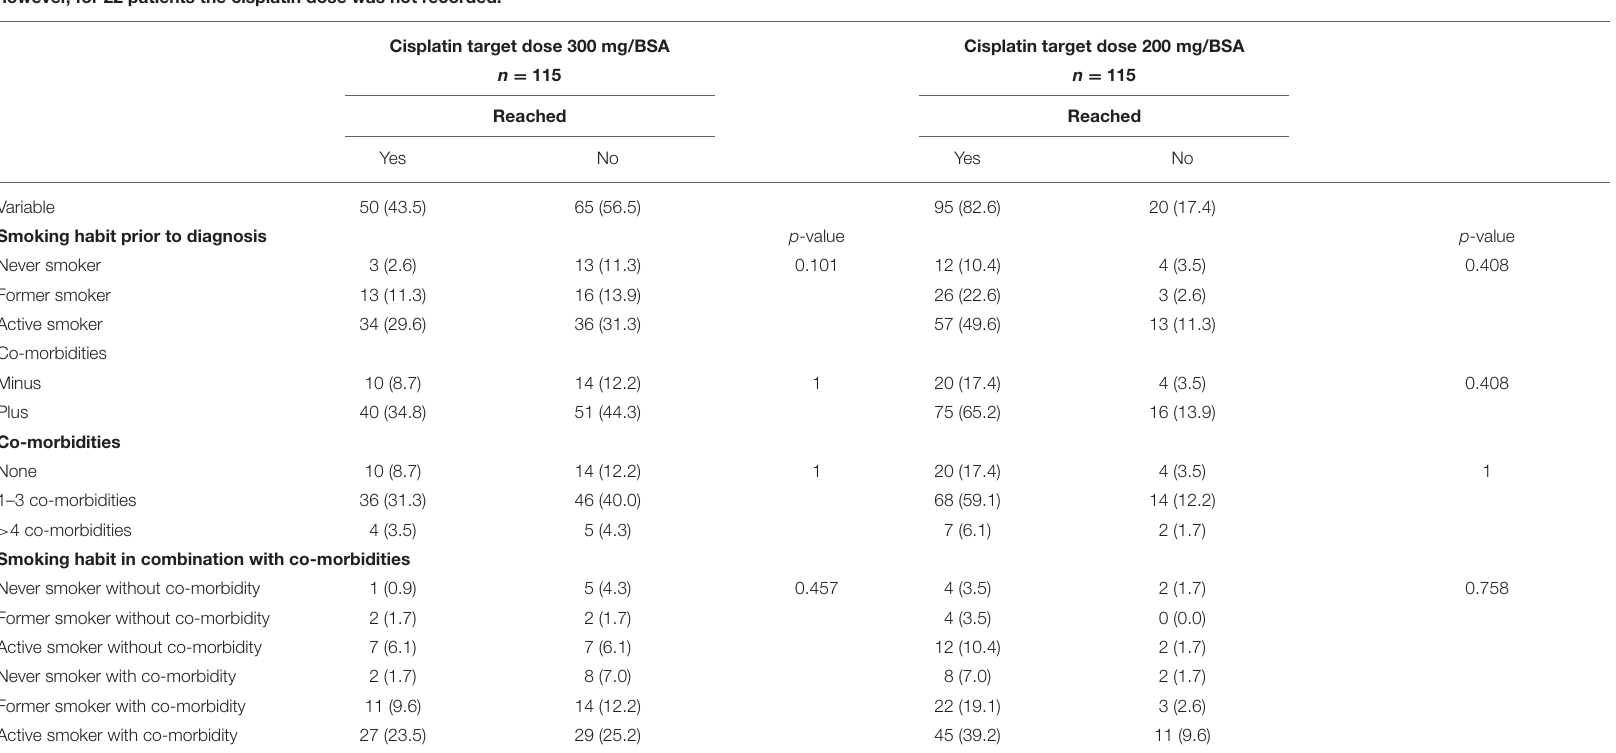
TABLE 4A | Correlation between therapy compliance during R(C)T treatment and the patients’ smoking habit, the occurrence of co-morbidities and the combination of both parameters. A: Reaching the cisplatin target dose during RCT treatment. Of the 232 patients treated by primary or adjuvant RCT 137 were treated with cisplatin, however, for 22 patients the cisplatin dose was not recorded.